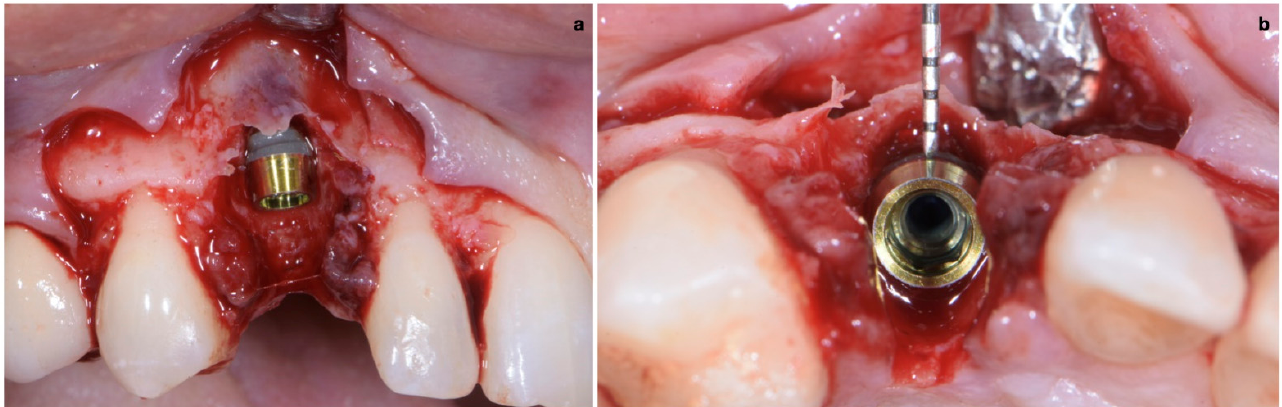
Figure 6. ( a , b ) Implant placement after guided preparation of implant site.